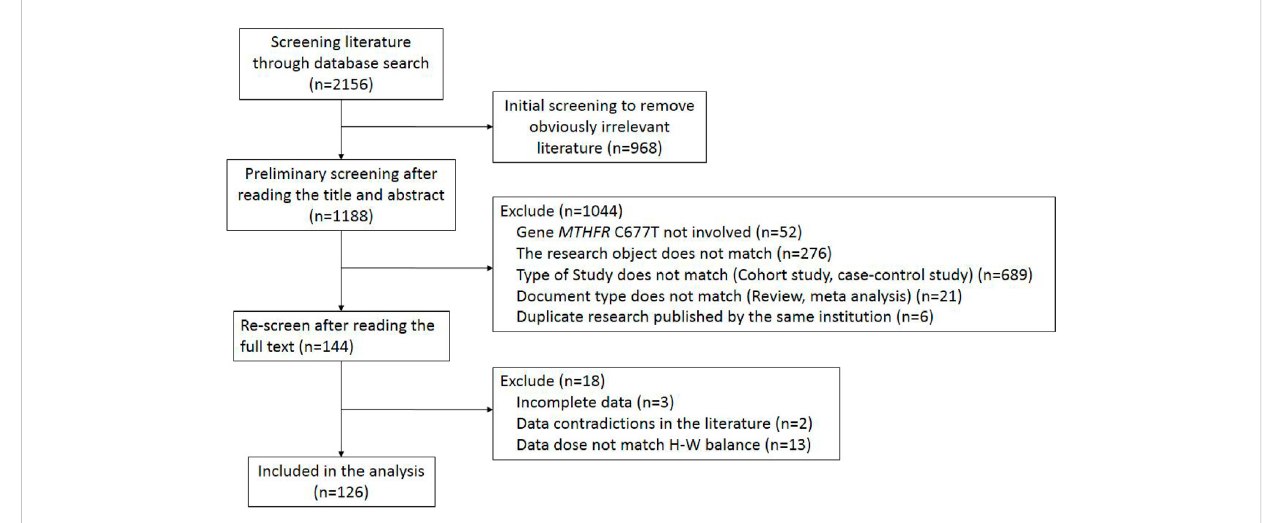
FIGURE 1 The fl owchart of literature screening